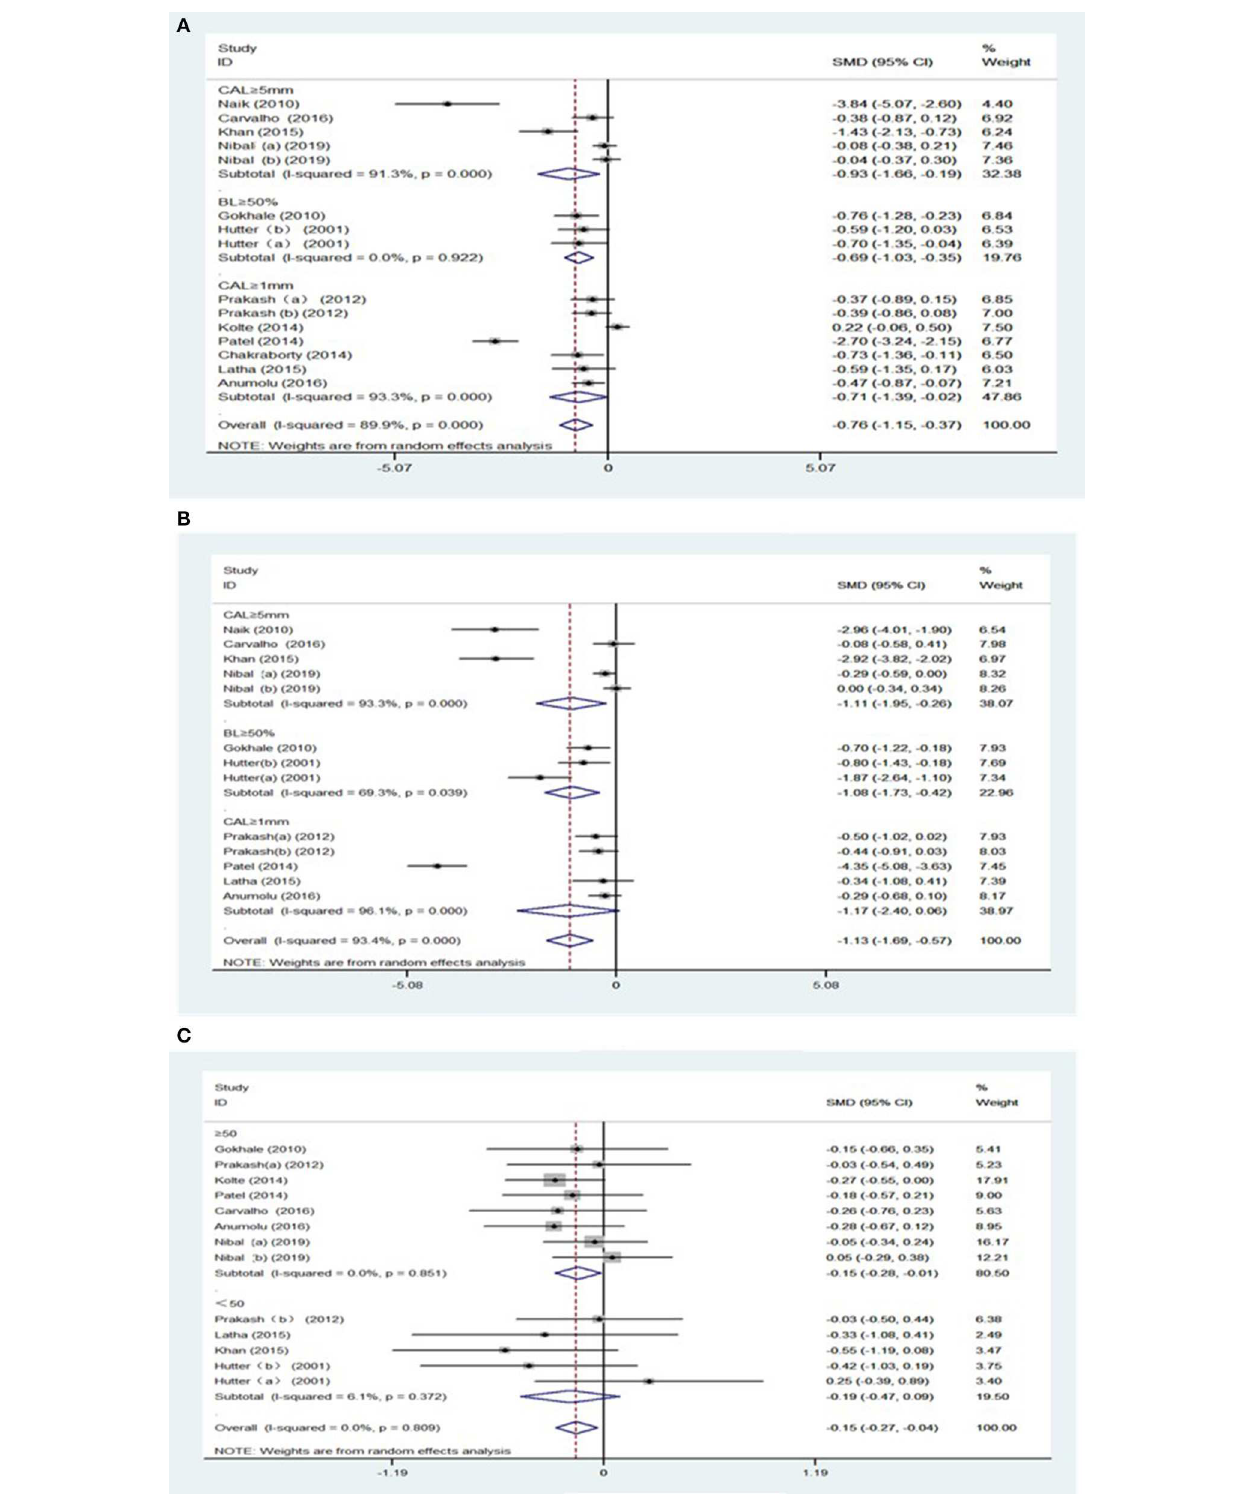
FIGURE 3 | Forest plot of the studies regarding the extent of periodontitis and sample sizes. (A) Forest plot of the studies regarding association between the extent of periodontitis and Hb; (B) Forest plot of the studies regarding association between the extent of periodontitis and HCT; (C) Forest plot of the studies regarding association between sample sizes and